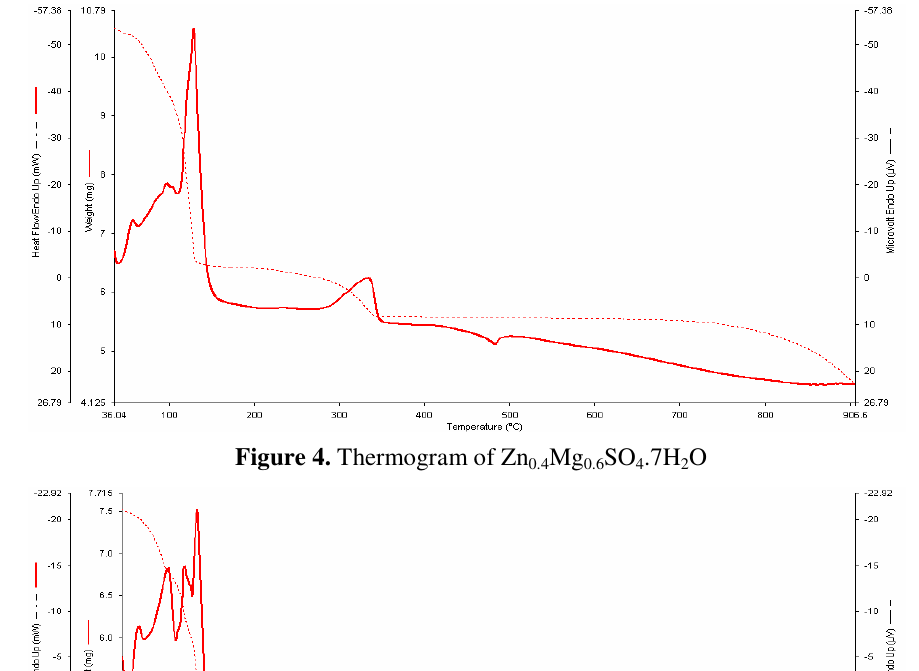
Figure 5. Thermogram of Zn